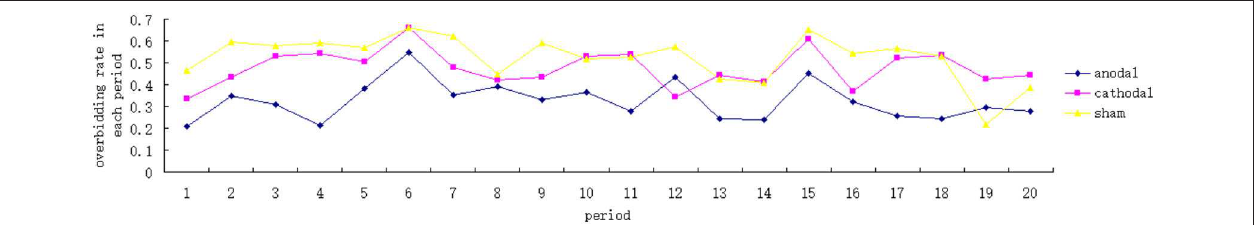
FIGURE 2 | Overbidding rate in each period across the three